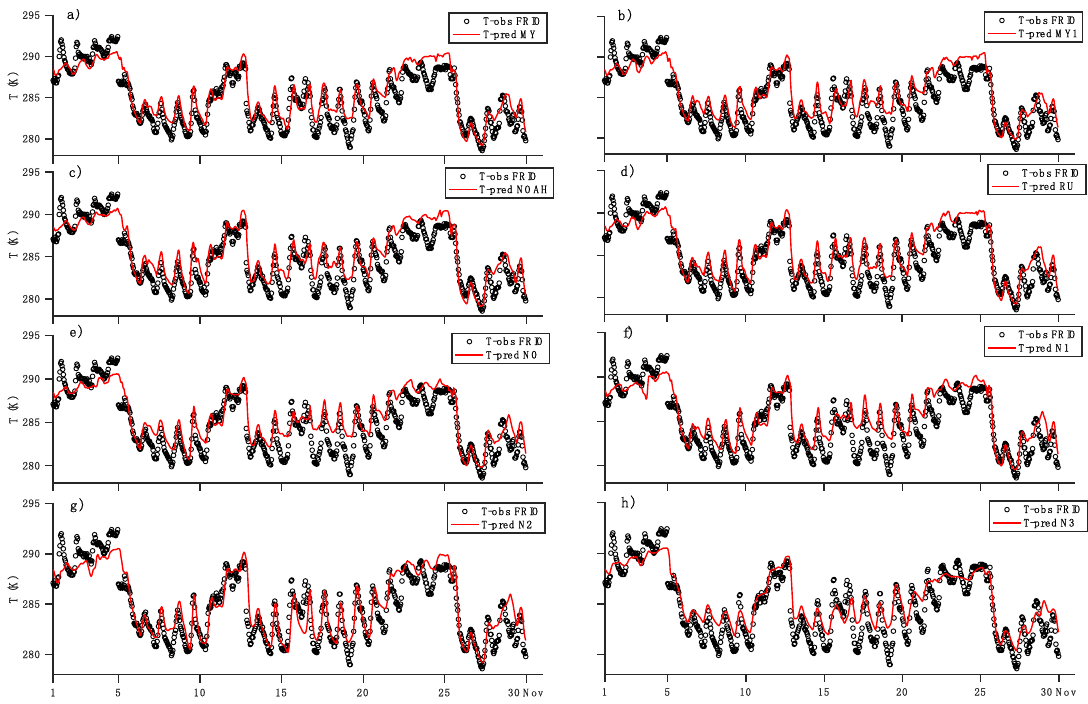
Figure 10. Time series of temperature (T) observed at FRIO meteorological station versus T predicted by MY ( a ), MY1 ( b ), NOAH ( c ), RU ( d ), N0 ( e ), N1 ( f ), N2 ( g ), and N3 ( h ) simulations.